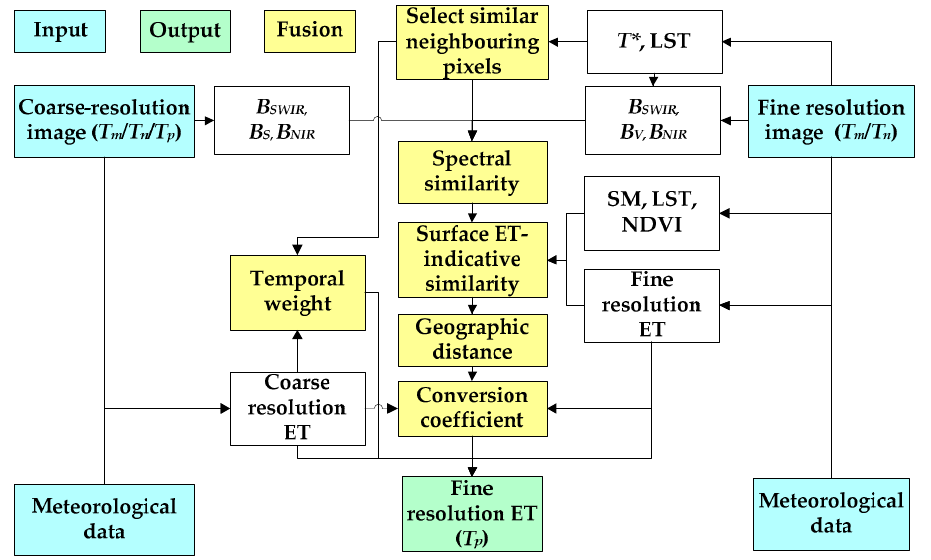
Figure 1. Schematic diagram of the spatio-temporal adaptive data fusion algorithm for evapotranspiration mapping (SADFAET).